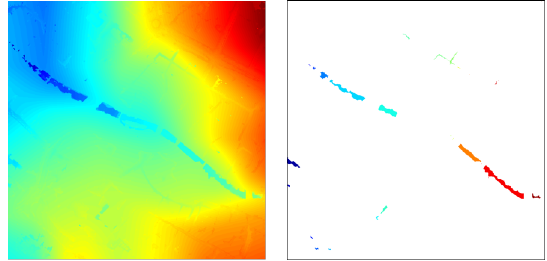
Figure 9. Elevation model EM (left), labeled areas for mesh computation (right).